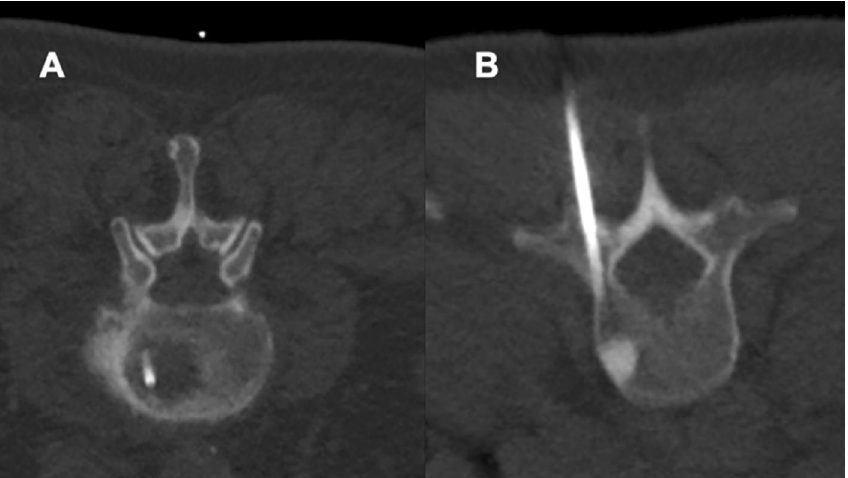
Figure 4. Exemplary patient cases for a L3 bone biopsy for a suspected bone tumor in a 77-year-old male using scanning with standard dose (SD; A ) and a L1 bone biopsy in a 49-year-old woman with a suspected bone metastasis from known breast cancer using scanning with low dose (LD; B ). The scans were rated with excellent image quality and high confidence.